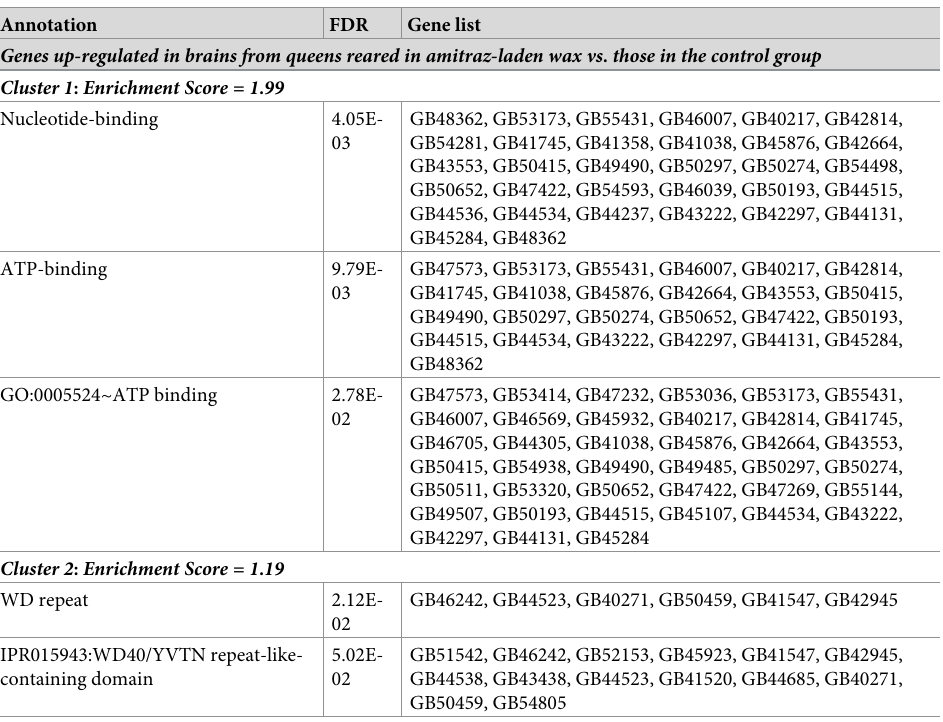
Table 6. Cluster analysis of differentially expressed genes in brain tissues from queens reared in wax containing amitraz ("A") compared to those reared in untreated (control) wax, using the online tool D.A.V.I.D. (Huang et al.